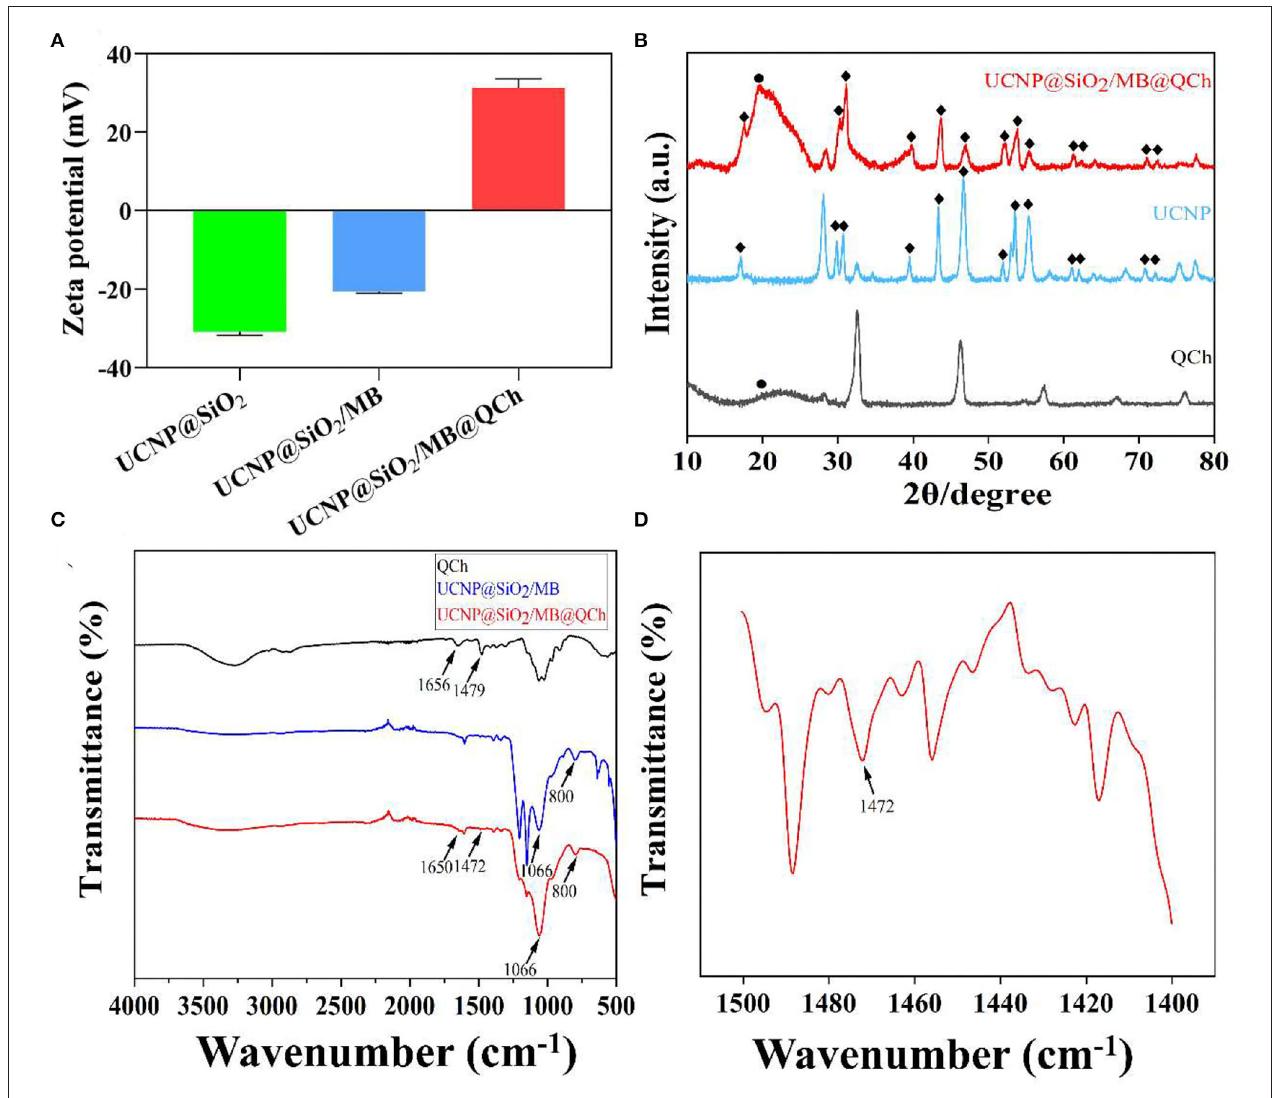
FIGURE 2 | (A) Zeta potentials of UCNPs@SiO 2 -based nanoparticles. (B) XRD patterns of QCh, UCNP, and UCNP@SiO 2 /MB@QCh. (C) FTIR spectra of QCh and UCNPs@SiO 2 -based nanoparticles. (D) The local enlarged FTIR spectrum of UCNP@SiO 2 /MB@QCh between 1,400 and 1,500 cm − 1 .